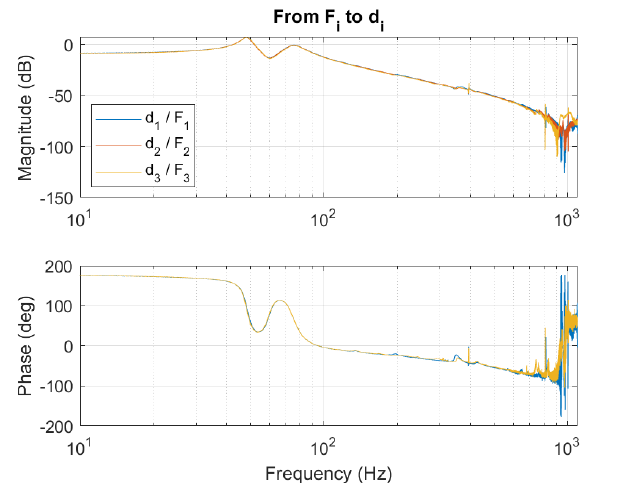
Figure 11. Frequency response function from actuator force to actuator displacement, the phase is shifted upwards by 180 degrees since the position is measured in opposite direction to applied